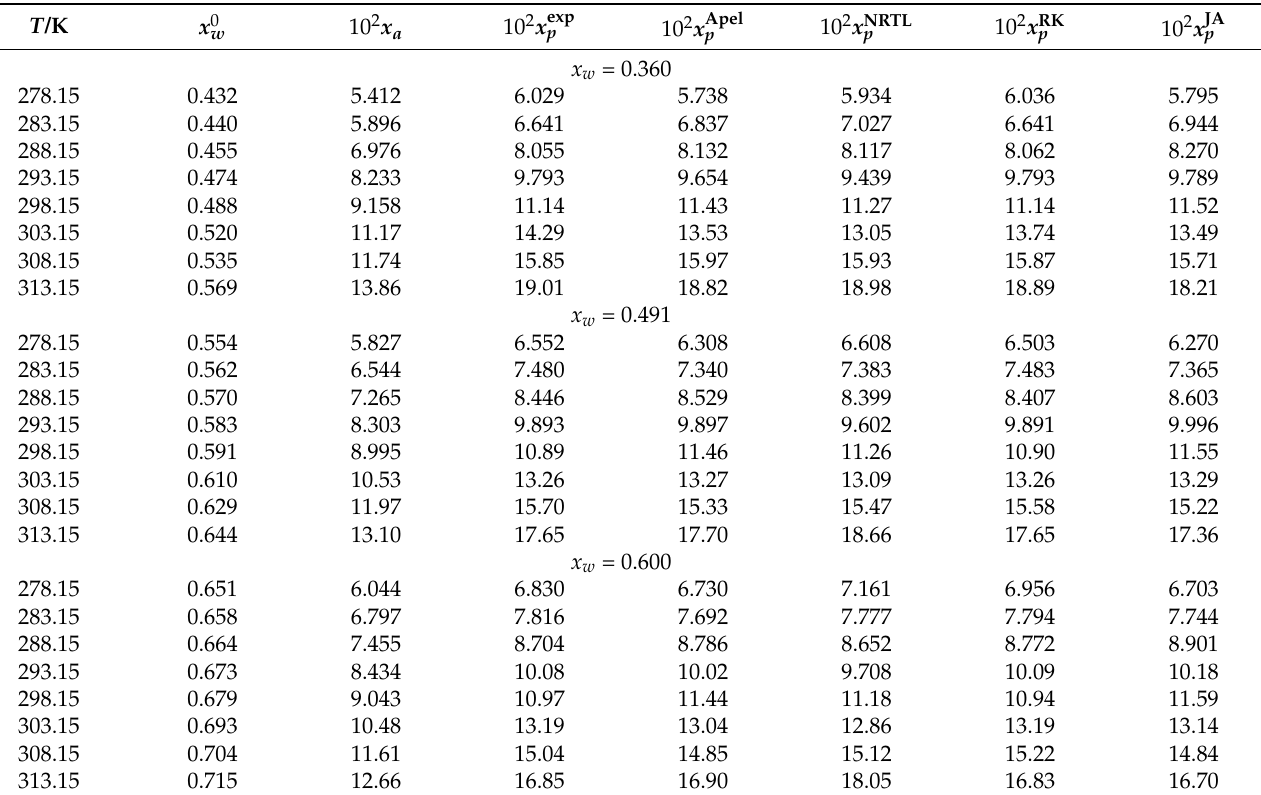
Figure 2. Powder X-ray diffraction pattern of raw material and residual solid in mixed systems: water + DMF ( x w = 0.648), water + ethanol ( x w = 0.447) and water + methanol ( x w = 0.360) at T = 298.15 K. Table 3. Mole fraction solubility of 1,5-pentanediamine adipate dihydrate in water + methanol from 278.15 K to 313.15 K ( p = 0.1 MPa) a,b